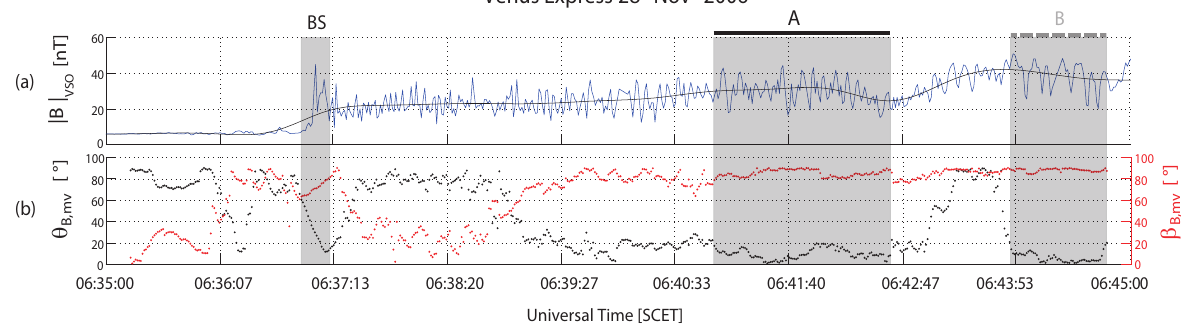
Figure 2. Time series of (a) magnetic field ( | B | ) and (b) angles between the maximum ( θ ) and minimum ( β ) variance directions and the background magnetic field, based on Venus Express data.